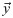
Illustration of the emergence of inhibitory subfields.A: Feedforward mapping from an input y→ to two neural units s1 and s2. The mapping is defined by two receptive fields with only positive entries. In this case, any strong activation of unit s2 does not negatively effect unit s1. For overlapping positive subfields, a stronger activation of s2 will even result in a stronger activation of s1 as well. B: Activations of neural units s1 and s2 according to a statistical model with non-negative generative fields (GFs). Both units compete to explain a presented input y→. A high probability for s2 decreases the probability of s1 and vica versa. This effect is known as “explaining away”, and it depends on the assumed model including the model for the combination of primitives, noise model, and prior. C: Illustration of an optimal feedforward mapping to approximate neural responses according to the statistical model in B. The stronger mutual suppression caused by explaining away is approximated by the introduction of inhibitory subfields. If the input is, e.g., now made stronger or less diffuse, then unit s2 can increase while unit s1 can simultaneously decrease, which is in accordance with probabilistic inference for a statistical model. D: Example of STRFs estimated from artificial data. The top row shows non-negative GFs. If the corresponding STRFs are now estimated using Eq 10, then negative subfields emerge (bottom row). For fields which do compete little with other fields (e.g., field three) the effect is the weakest. The strongest effects are observed for fields with large overlap (e.g. fields four and six). In general, explaining away effects increase with overcompleteness, i.e., with the number of GFs compared to input size. Color scales for all subfigures as in Fig 2A.